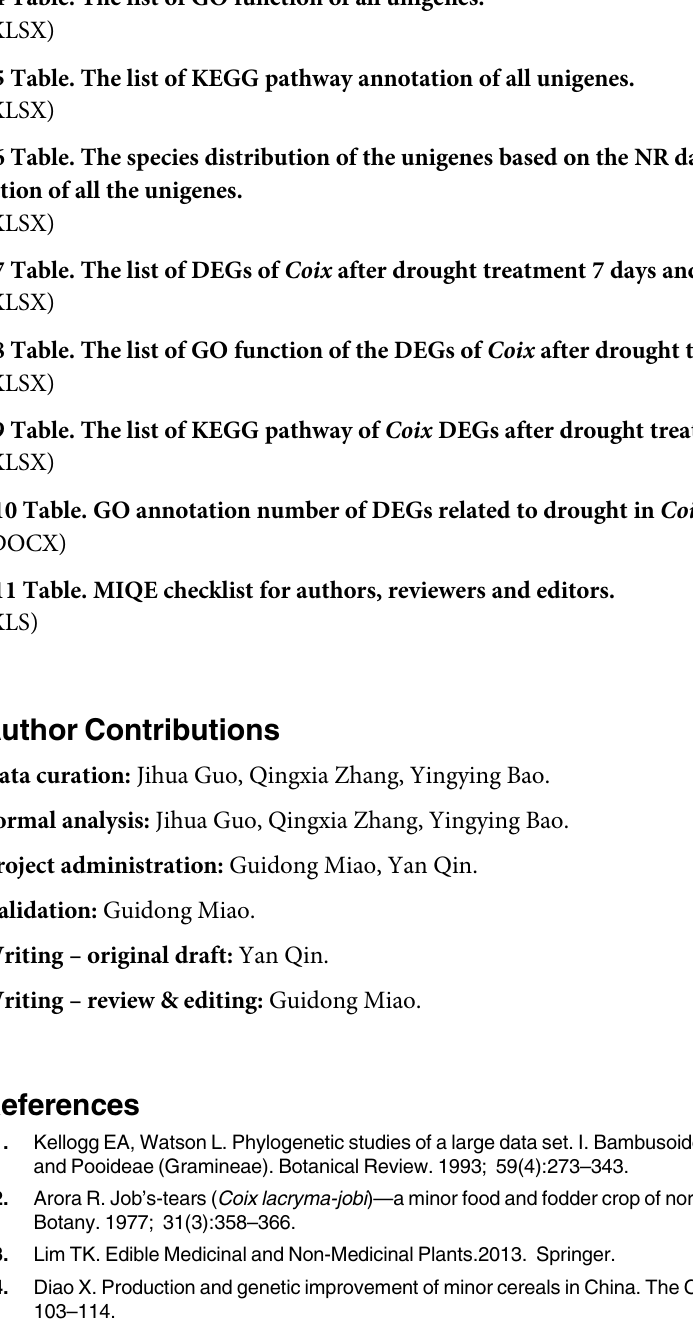
S2 Table. The assembled unigenes and their functional annotation. S3 Table. List of unigenes of Coix annotated in COG for functional annotation and classifi-